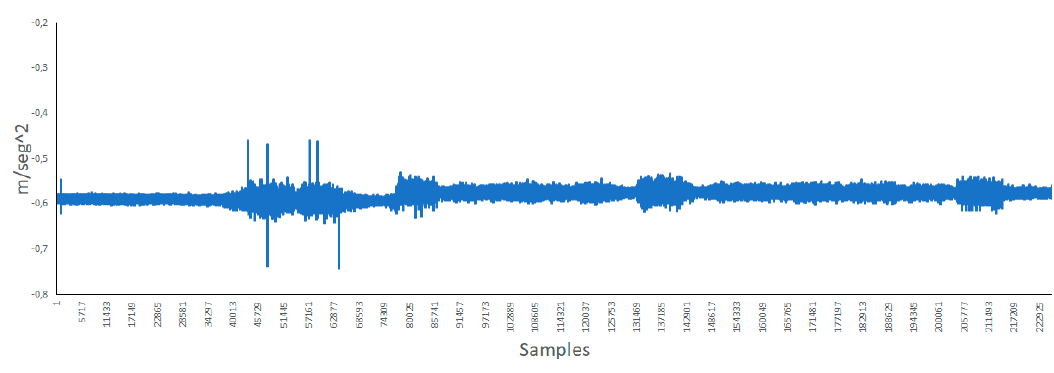
Figure 8. Data of the x axis of the accelerometer.